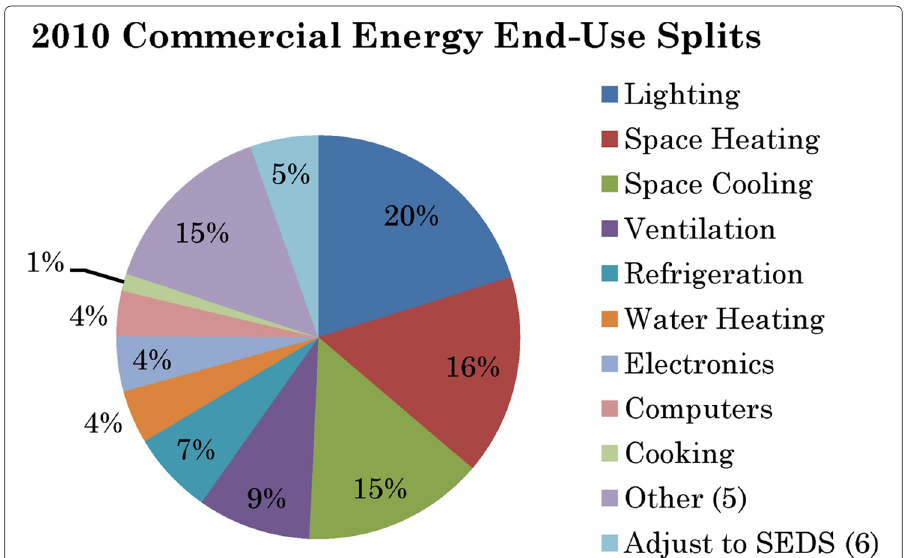
Fig. 1 Energy end-use split for commercial buildings in the US (Energy U.S.D.o. 2011). As seen, Space Heating accounts for 16% of the energy consumption and Ventilation for 9%, which are the two uses in which